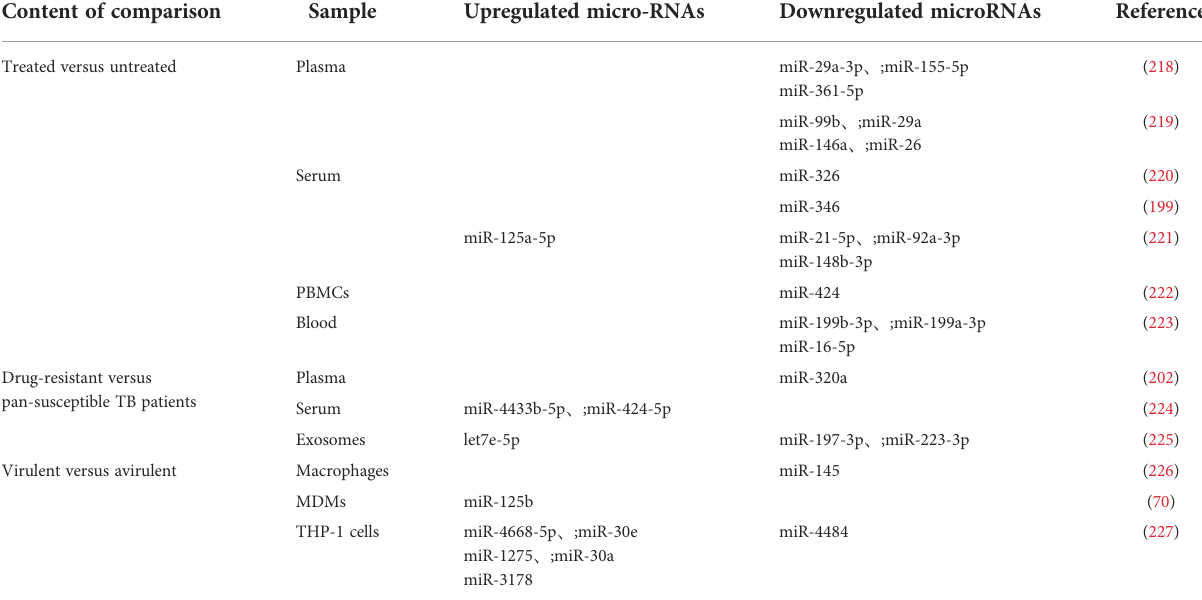
TABLE 2 microRNAs as biomarkers in